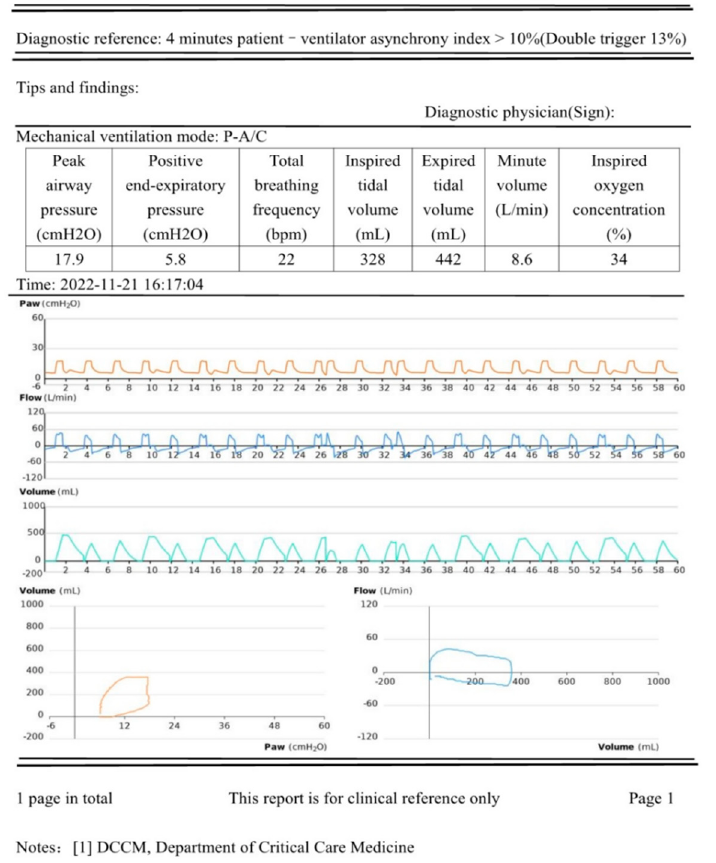
Figure 5. Double triggering data analysis report.